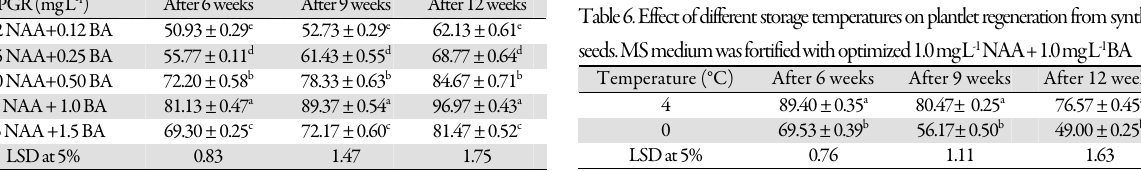
Table 4. Effect of various NAA and BA concentrations on plantlet recovery from synthetic seeds in MS medium PGR (mg L -1 ) After 6 weeks